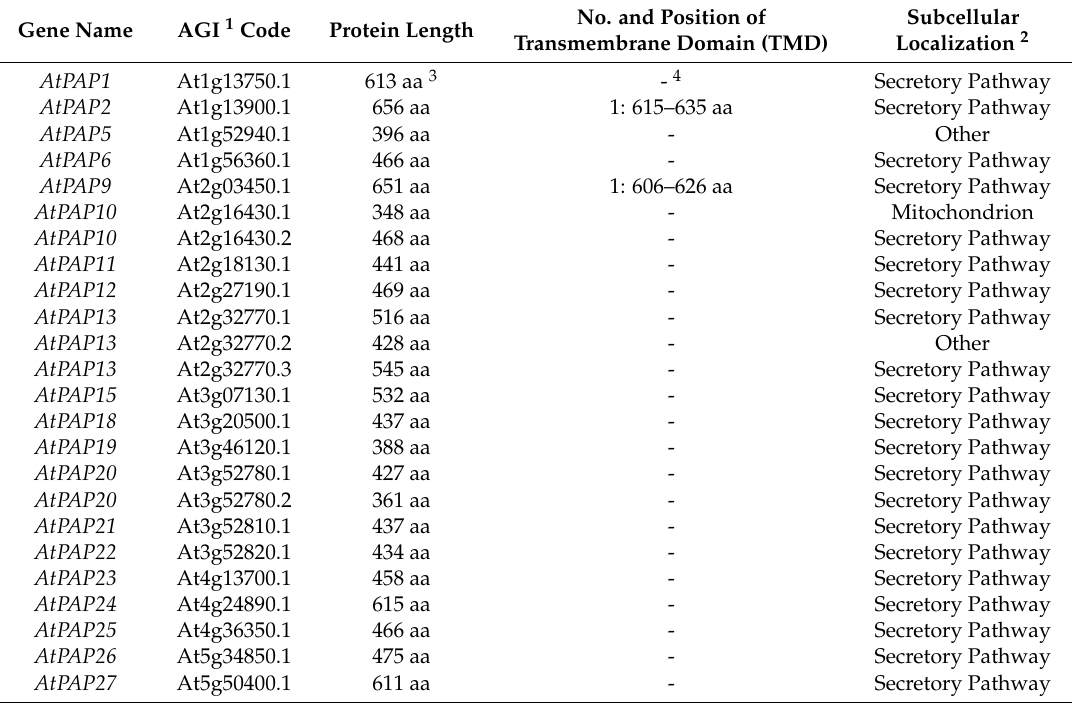
Table 1. A bioinformatics analysis of the targeting of purple acid phosphatases (PAPs) in Arabidopsis.